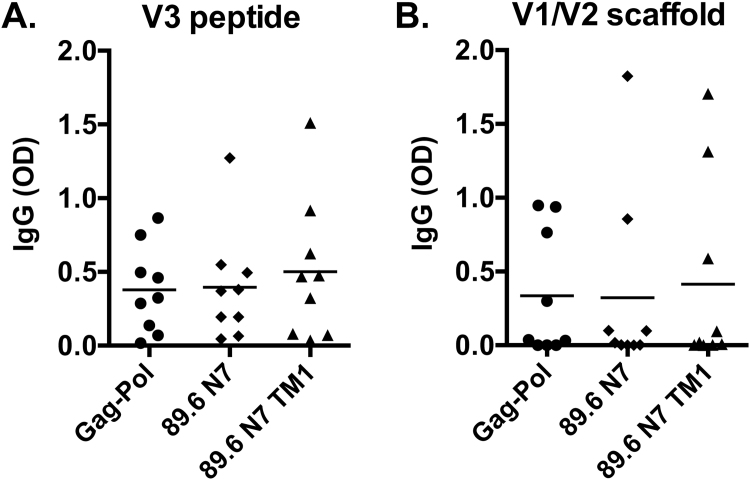
No difference in V3 and V1/V2 epitope-specific IgG responses due to TM1 modification. (A) V3-specific and (B) V1/V2-specific IgG responses were assayed by ELISA using synthetic V3 peptide and MLV gp70-scaffolded V1/V2, respectively, as the coating antigens and post-boost two serum diluted (A) 1:2000 or (B) 1:200. Points represent OD values for individual mice and horizontal lines indicate the mean. Groups were not statistically different (p > 0.05) by Kruskal-Wallis test with Dunn's correction.